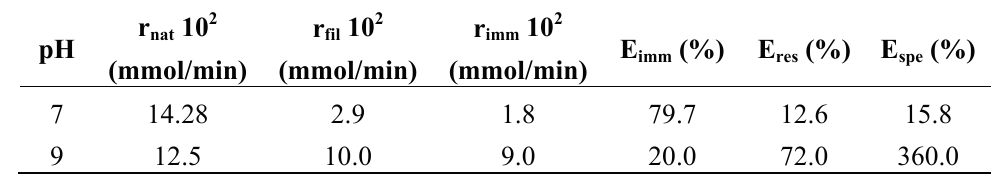
Table 1. Percentage of immobilized enzyme, E activity of the immobilized enzyme, E catalytic activity (mmol/min) of the free native enzyme, r the immobilization process, r linker p -hydroxybenzaldehyde. The lipase immobilization has been carried out at pH 7 and 9 and at 30